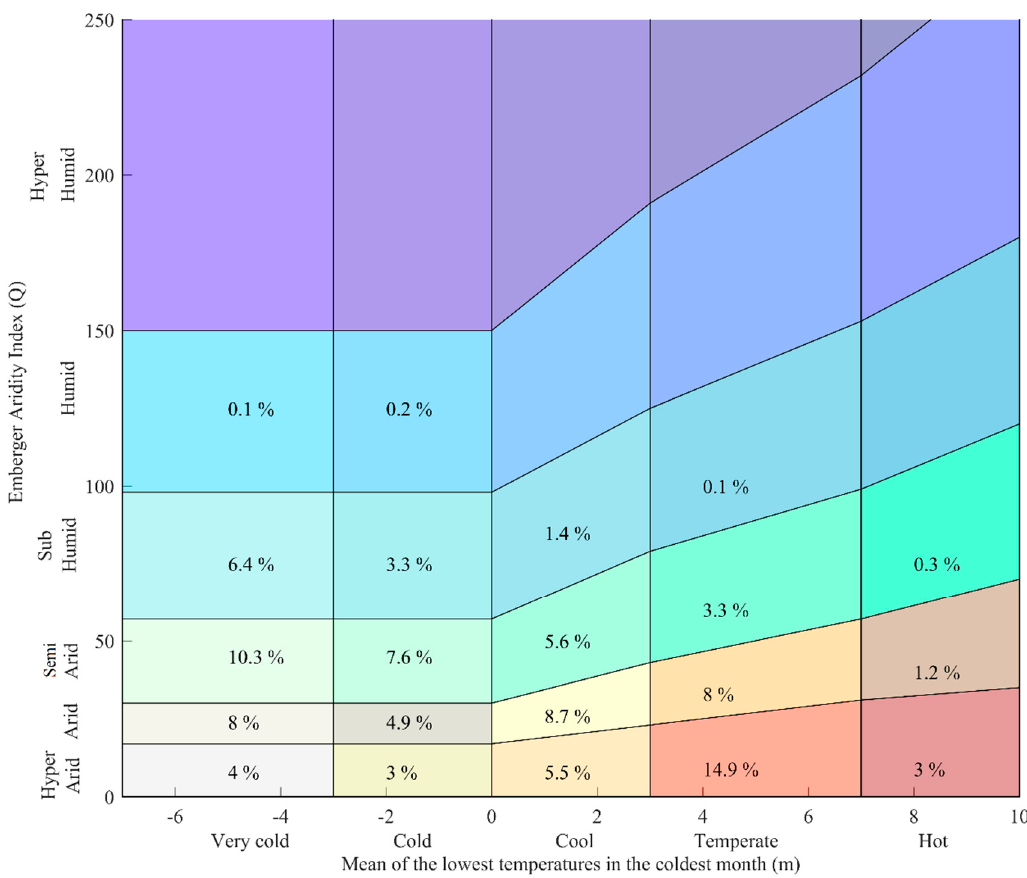
Figure 2. Emberger climatogram and percentage area covered by different climate types at 26 meteorological stations across Fars province (1976–2015).